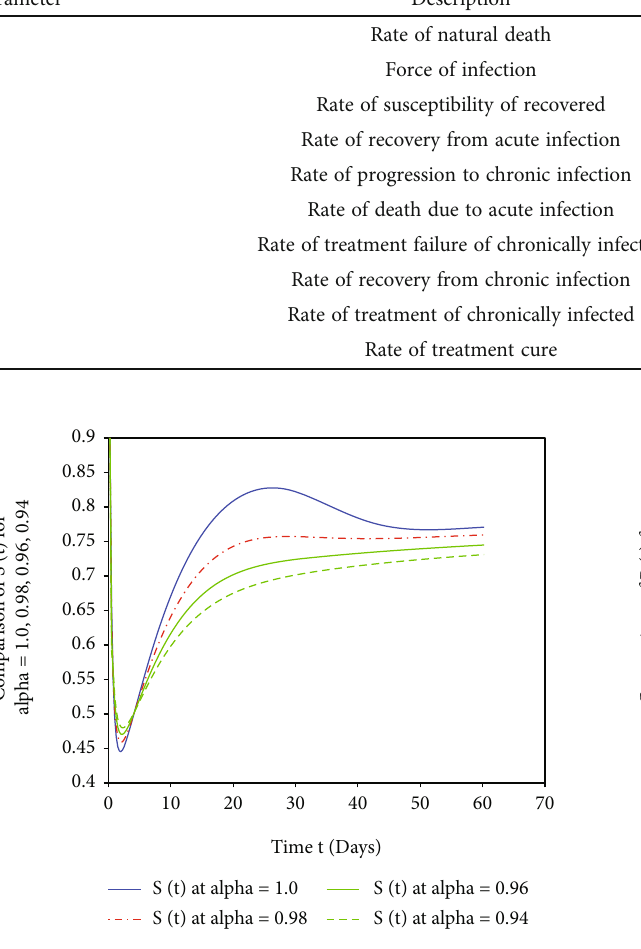
Figure 5: The susceptible class S ð t Þ for ϱ = 1 : 0, 0 : 98, 0 : 96, 0 : 94 .